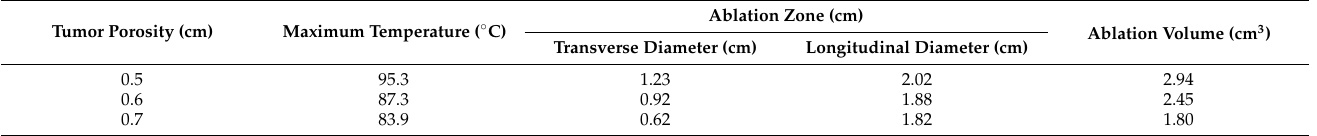
Table 6. Ablation temperature, ablation area and ablation volume of tumors with different porosities.